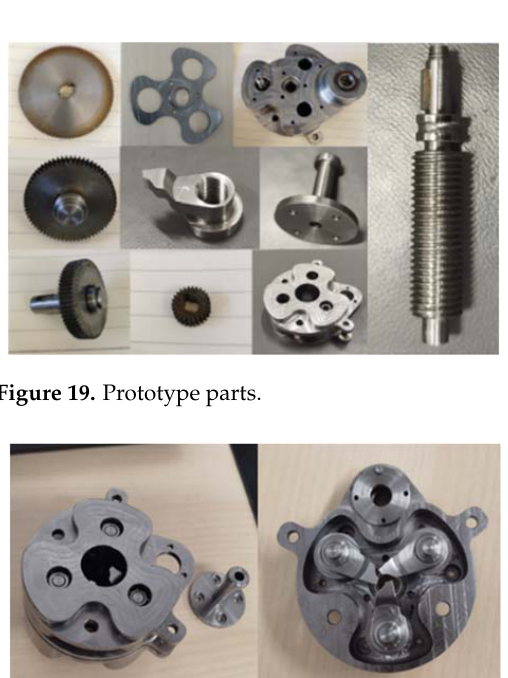
Figure 19: locking rod, locking claw, transmission rod, central shaft, upper bearing, lower